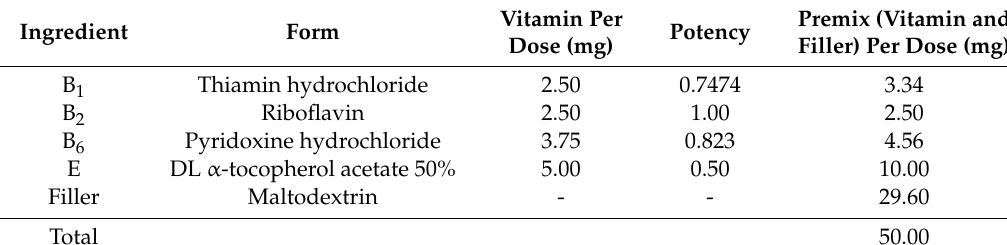
Table 1. Composition of vitamin premix for Level 1